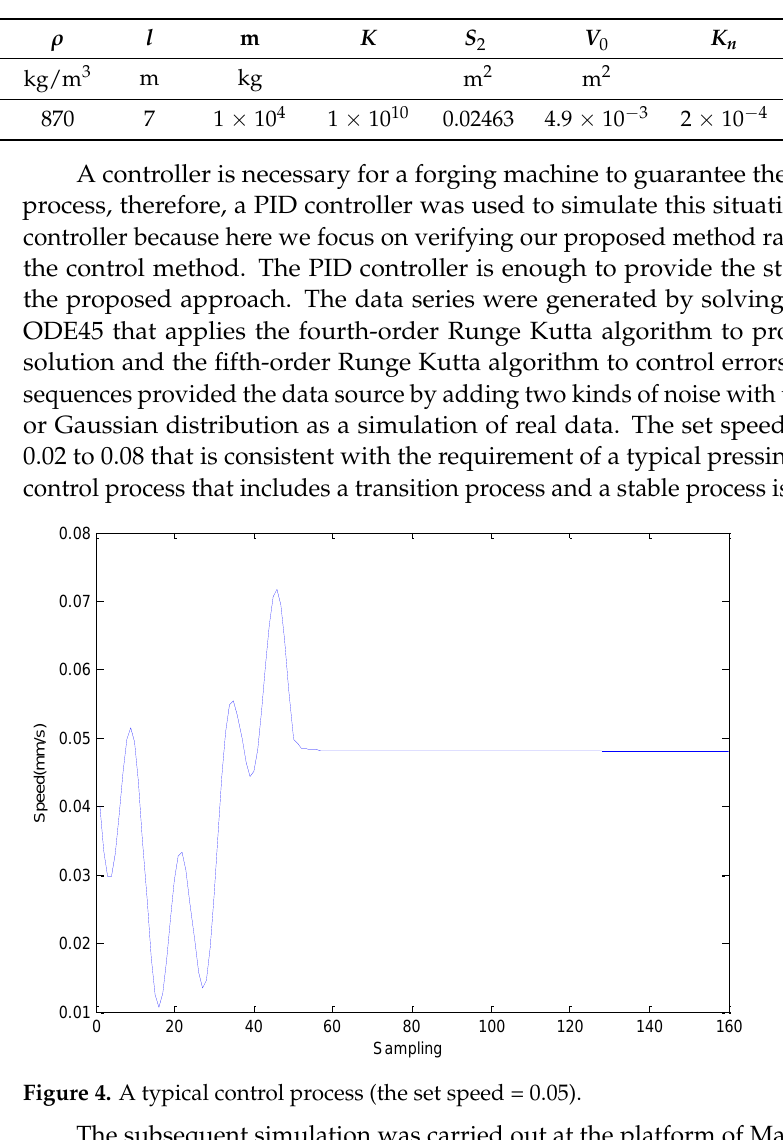
Figure 5. The episode training process of viscous damping coefficient (B was predetermined as 15).